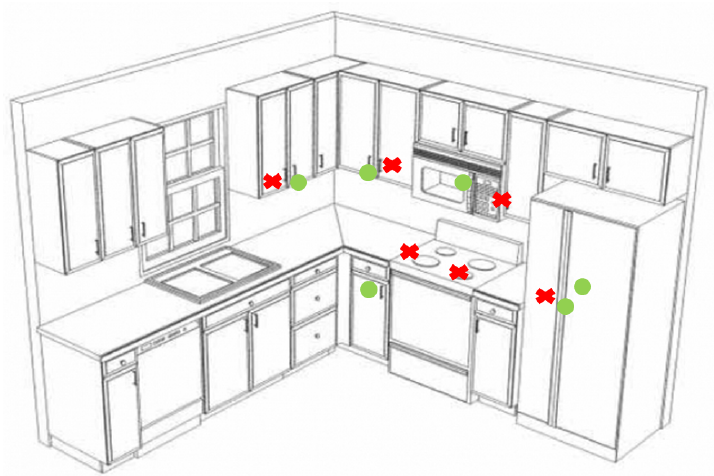
Figure 17. Example of interaction